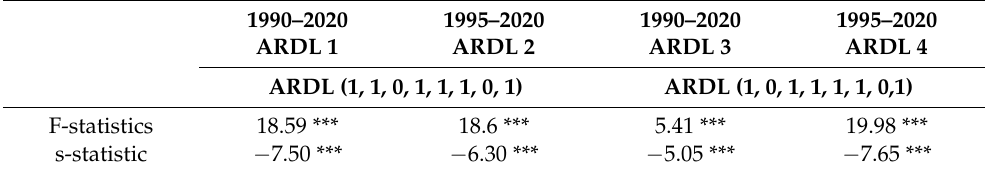
Table 2. Cointegration test